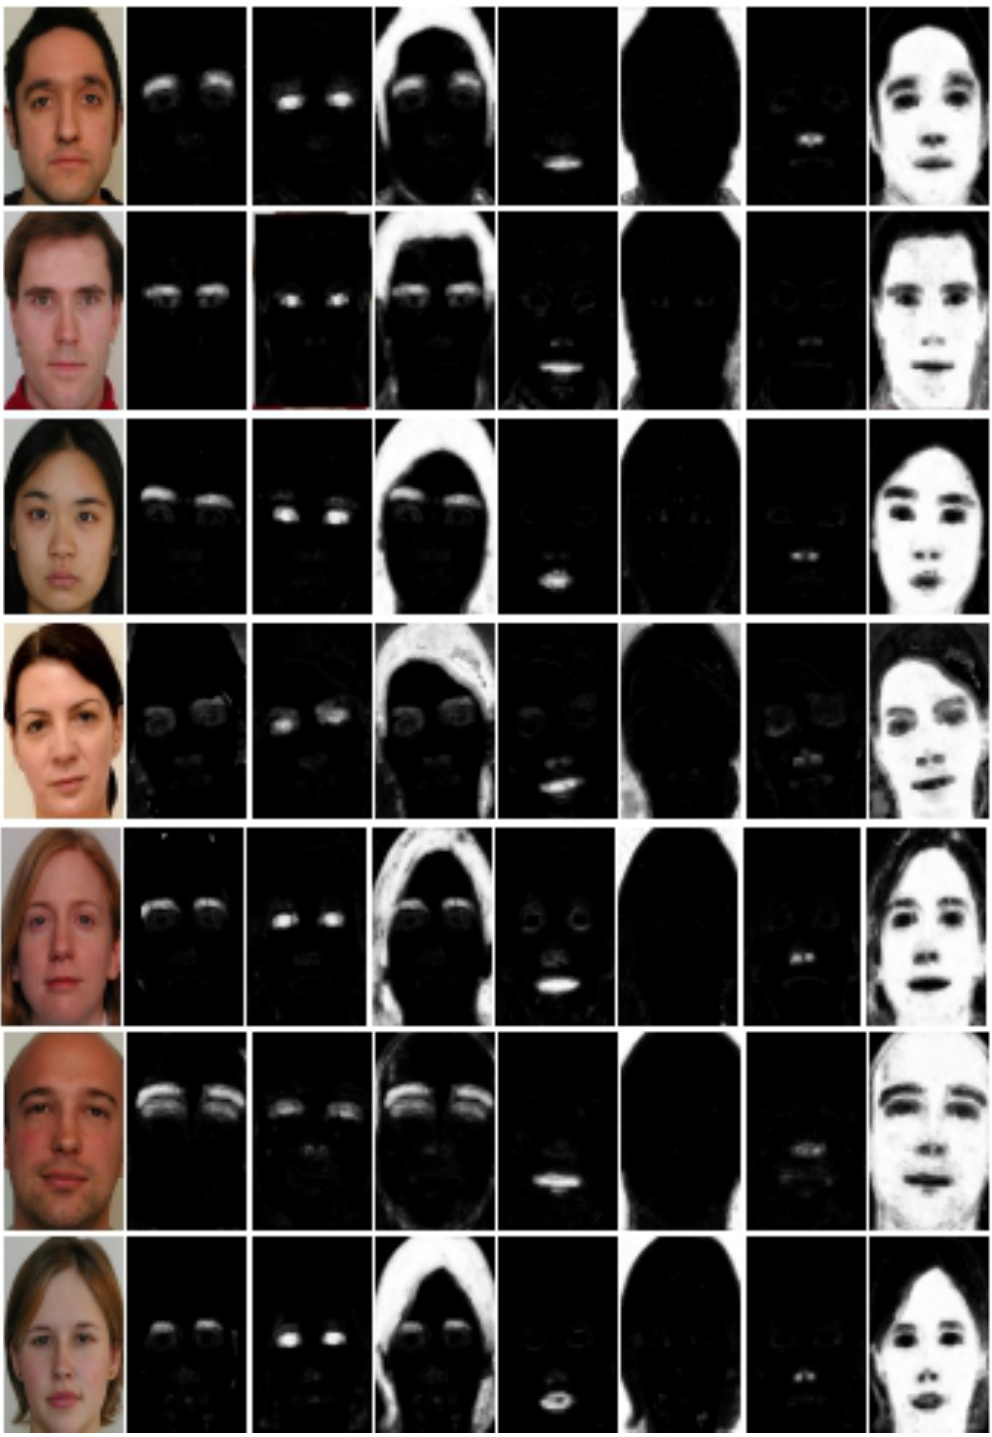
Figure 5. Example face images from FASSEG [29] database, probability maps in the order such that: column 1 shows: original images, 2: eyebrow, 3: eyes, 4: hair, 5: mouth, 6: back, 7: nose, and 8: skin